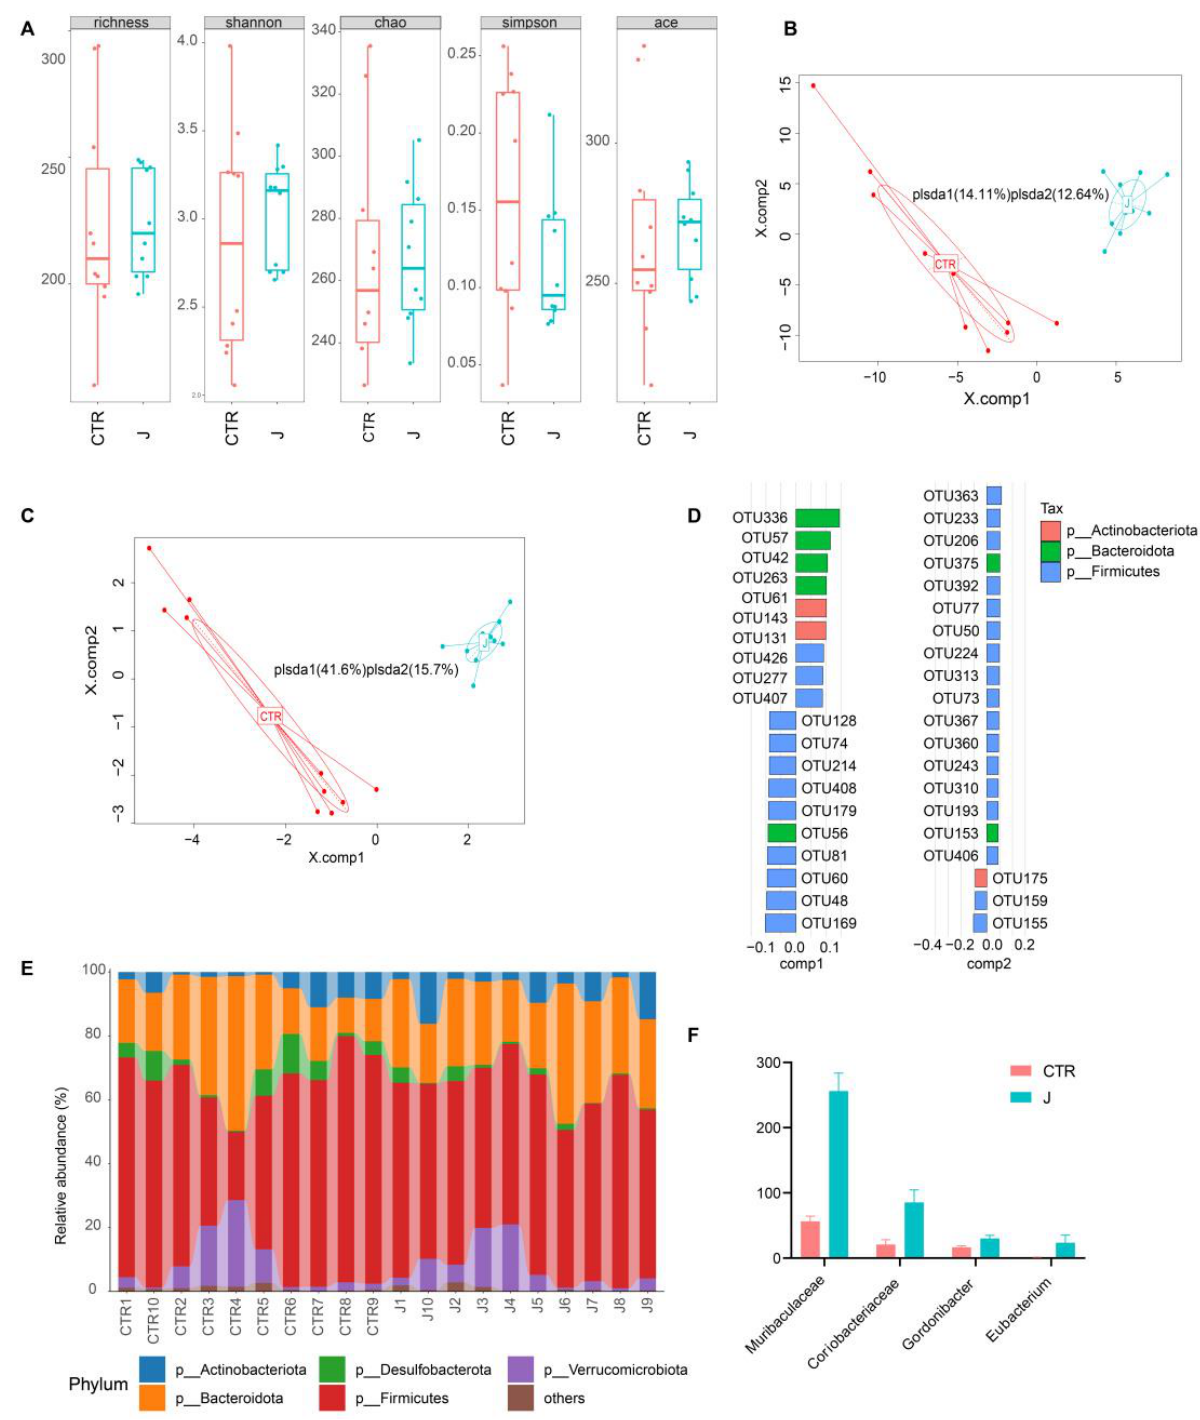
Figure 4. The impact of jujube on gut microbiota diversity and compositions. ( A ) Pre-administration of jujube for a week affected the alpha diversity of gut microbiota according to different indexes. ( B ) Partial least squares discriminant analysis based on OTU abundance. ( C ) Partial least squares discriminant analysis based on the top five representative OTU abundance. ( D ) The critical OTUs conducive to partial least squares discriminant analysis component 1 and component 2. ( E ) The difference in the gut microbiota composition of each mouse at the phylum level. ( F ) The relative abundance of Muribaculaceae , Coriobacteriaceae , Gordonibacter , and Eubacterium in the jujube group and the control